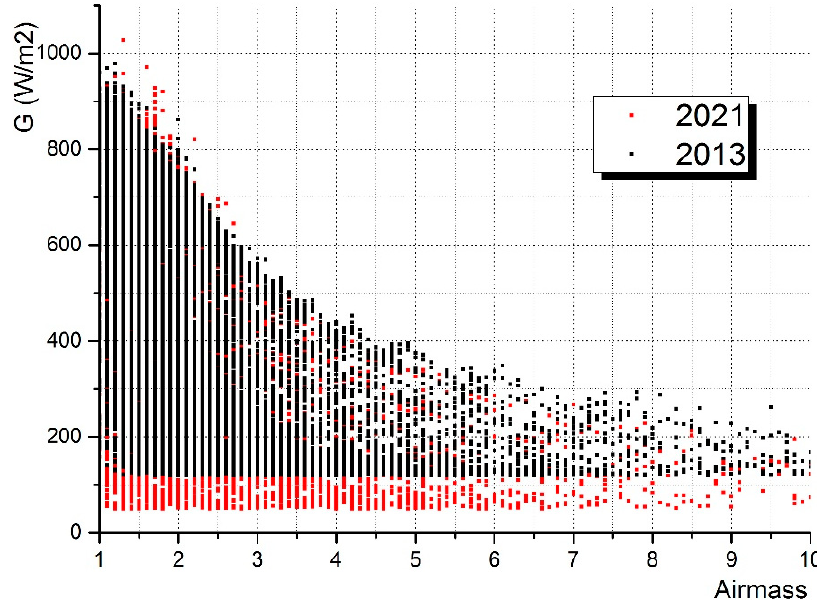
Figure 15. Comparison of measured Irradiance of 2013 and 2021 in correlation with airmass.